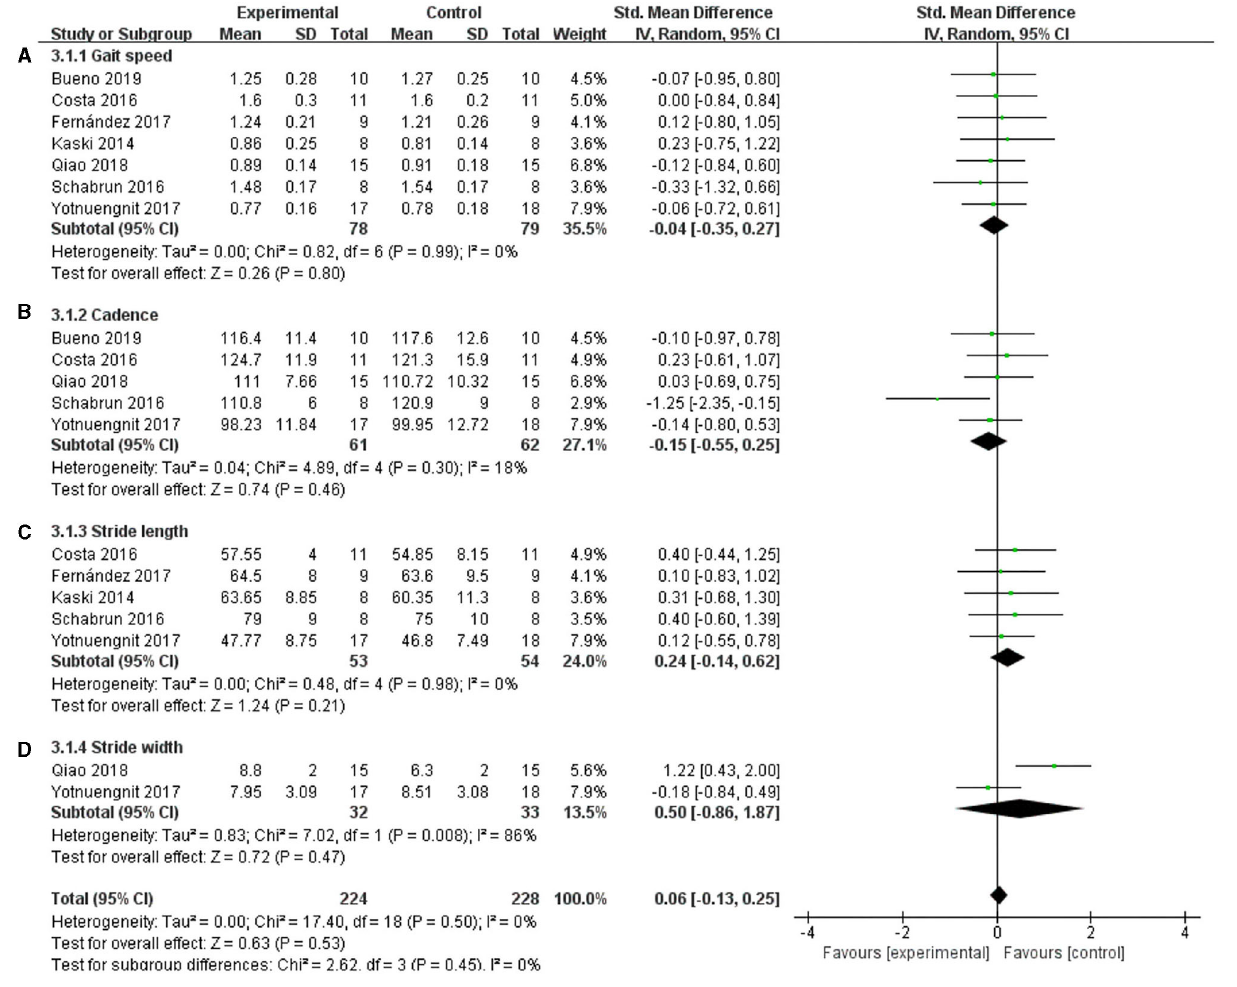
FIGURE 8 | Effects of tDCS on gait scores in PD patients. (A) Effect of tDCS on gait speed in patients with PD. There was a non-significant pooled effect size ( p = 0.80). (B) tDCS had a non-significant effect on the cadence of PD patients ( p = 0.46). (C) tDCS had a non-significant effect on the stride length of PD patients ( p = 0.21). (D) Effect of tDCS on the stride width of patients with PD. A non-significant pooled effect size was observed ( p = 0.47). CI, confidence intervals; PD, Parkinson’s disease; SD, standard deviation; tDCS, transcranial direct current stimulation; TUG, timed up and go